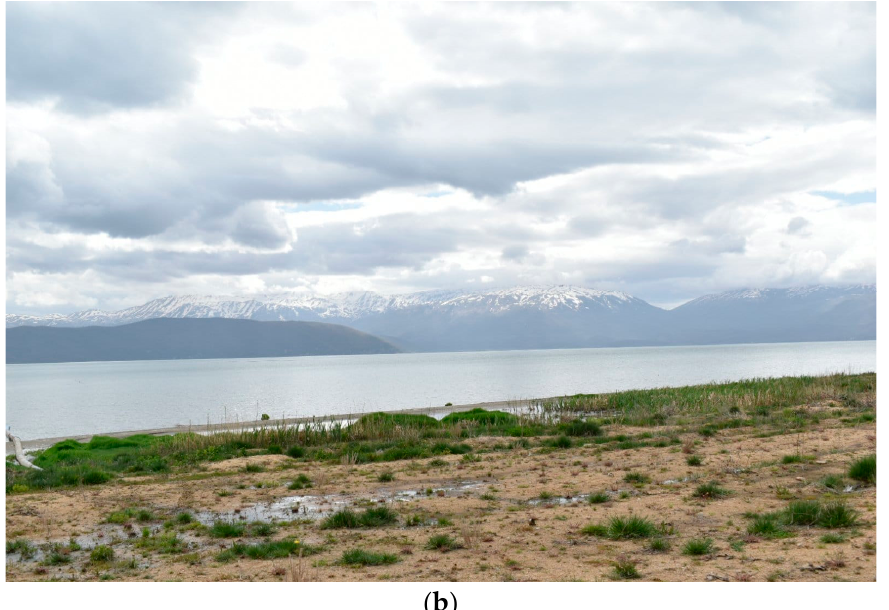
Figure 1. ( a ) Location map of Ohrid and Prespa lakes in the Balkans. The blue line indicates the watershed of Prespa. Source map: Landsat-8 Imagery in September 2020, processed by J.S. ( b ) View from E to NW, from Pretor to Galichica mountain in spring 2022. Source: N.A.